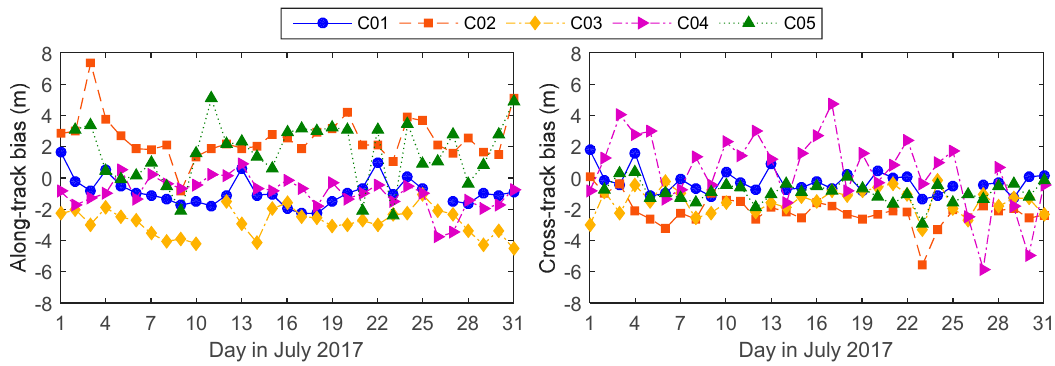
Figure 9. Estimated daily systematic orbit biases in along-track and cross-track of GBM BeiDou GEO orbit products published by GFZ during July 2017 in FY-3C POD. The left and right subgraphs denote the daily orbit bias series in the BeiDou GEO orbit along-track and cross-track, respectively. Different color points are prepared for different GEO satellites.